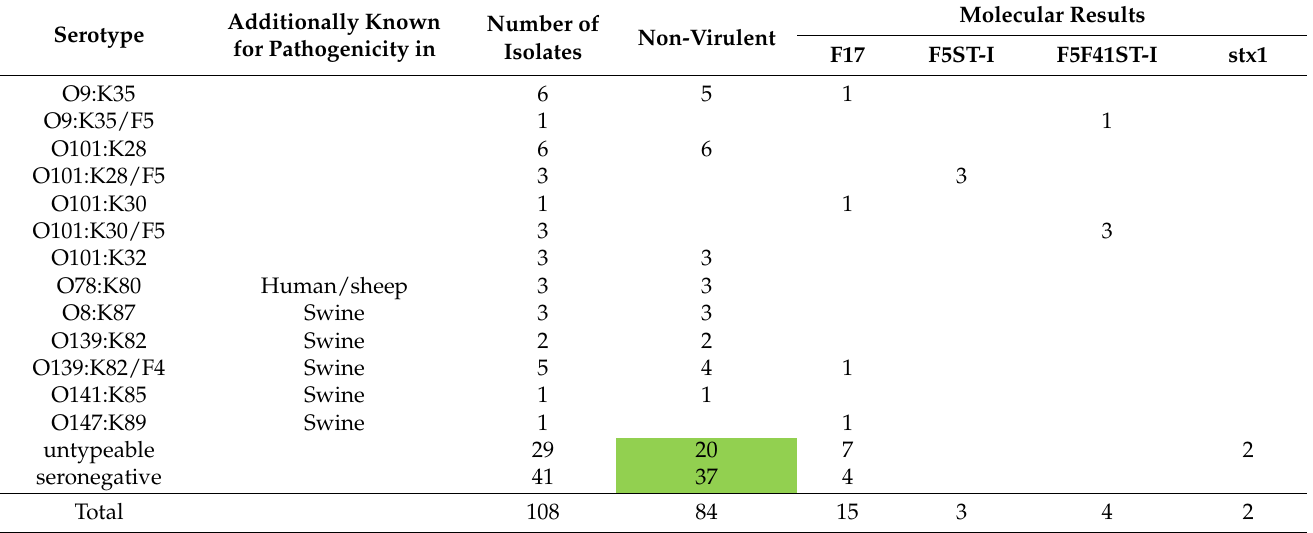
Table 2. The serologic and molecular characterization revealed 13 different serotypes known to be pathogenic for cattle and other species. Furthermore, four different genotypes were detected with five different coding sequences for fimbria and/or toxins in one or more isolates. Some of the isolates were untypeable/ seronegative and did not reveal any of the investigated virulence factors (green